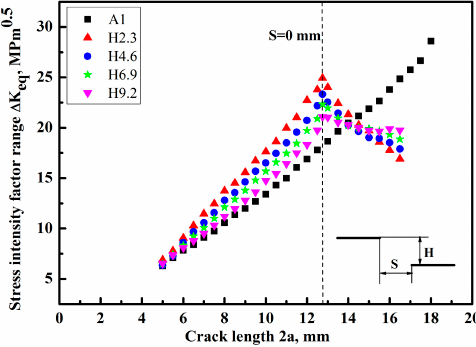
Figure 6. The Δ K eq varying with the crack growth length 2a.